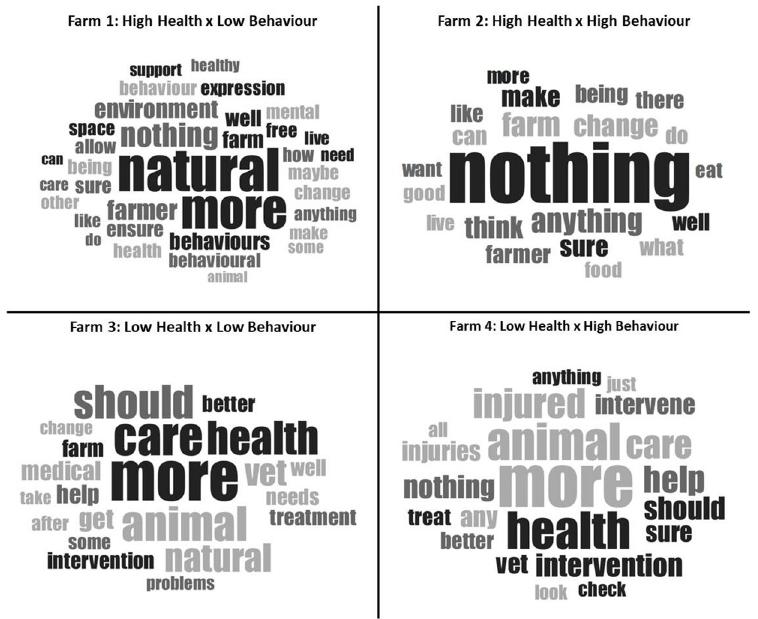
Fig 4. Wordcloud of qualitative responses to what participants would change about vignette